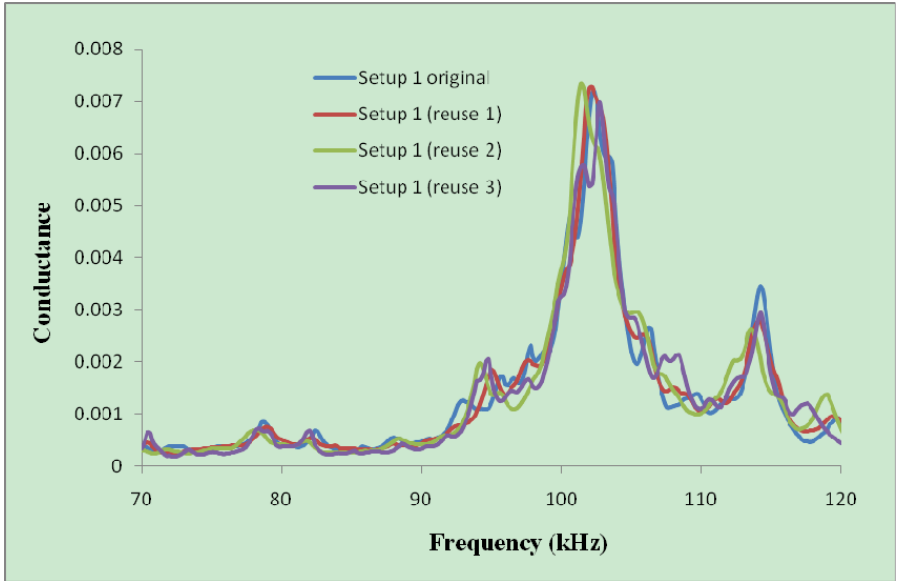
Figure 9. The initial signature obtained from setup after installing inside the